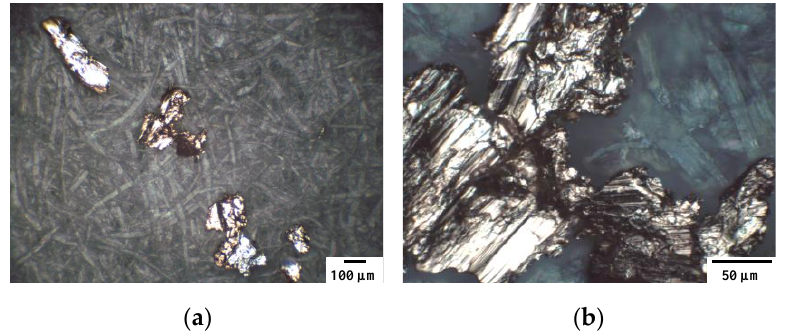
Figure 5. Micrographs of wear particles collected after the experiment: ( a ) the shape and ( b ) the surface.